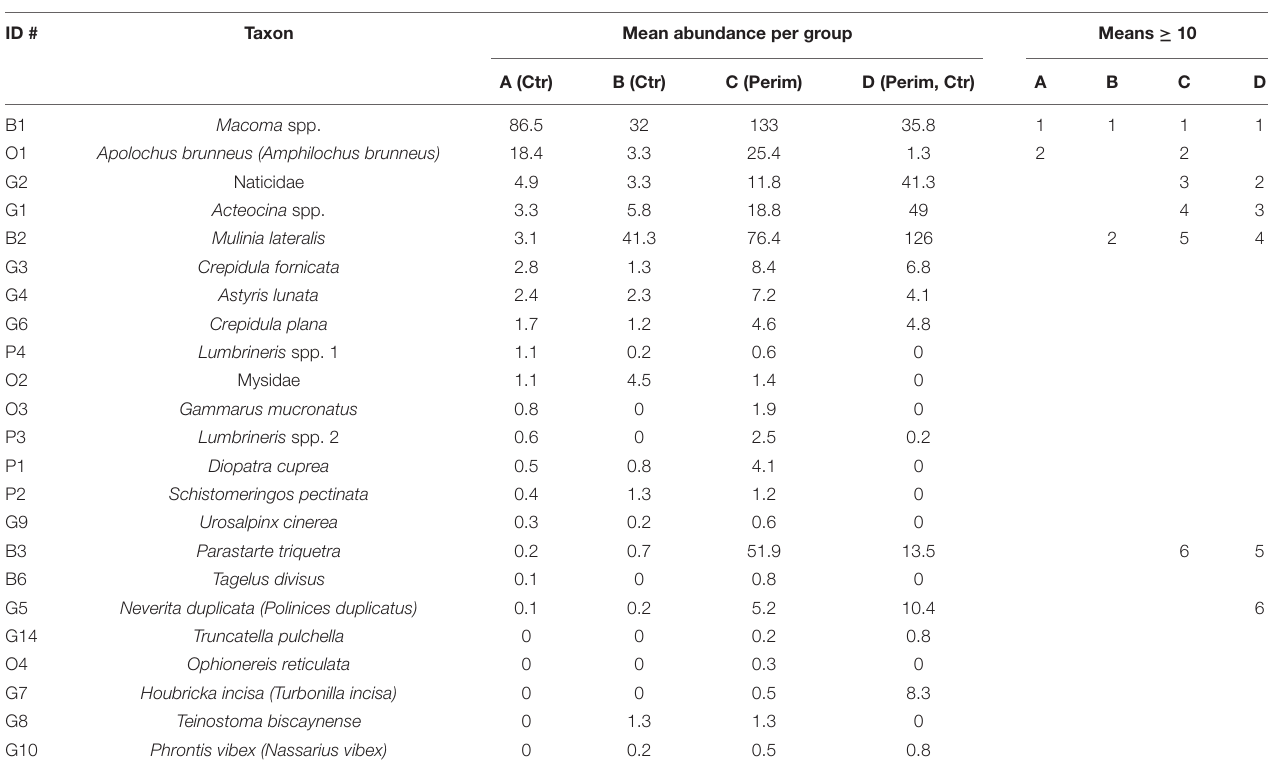
TABLE 4 | Similarities percentage analysis of mean abundances (individuals per grab) for the four groups that were determined from hierarchical cluster